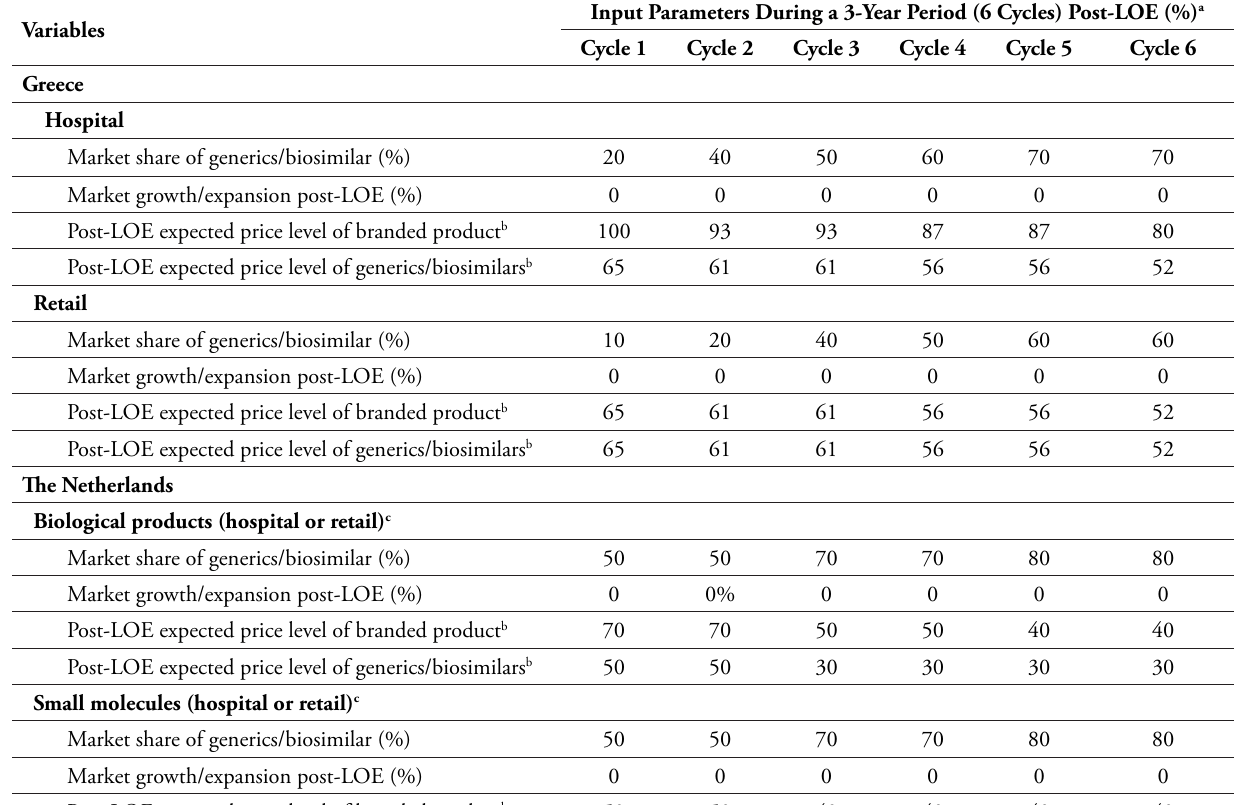
Table 1. Input Parameters for Scenario Analyses in Greece, the Netherlands, Norway, and Sweden